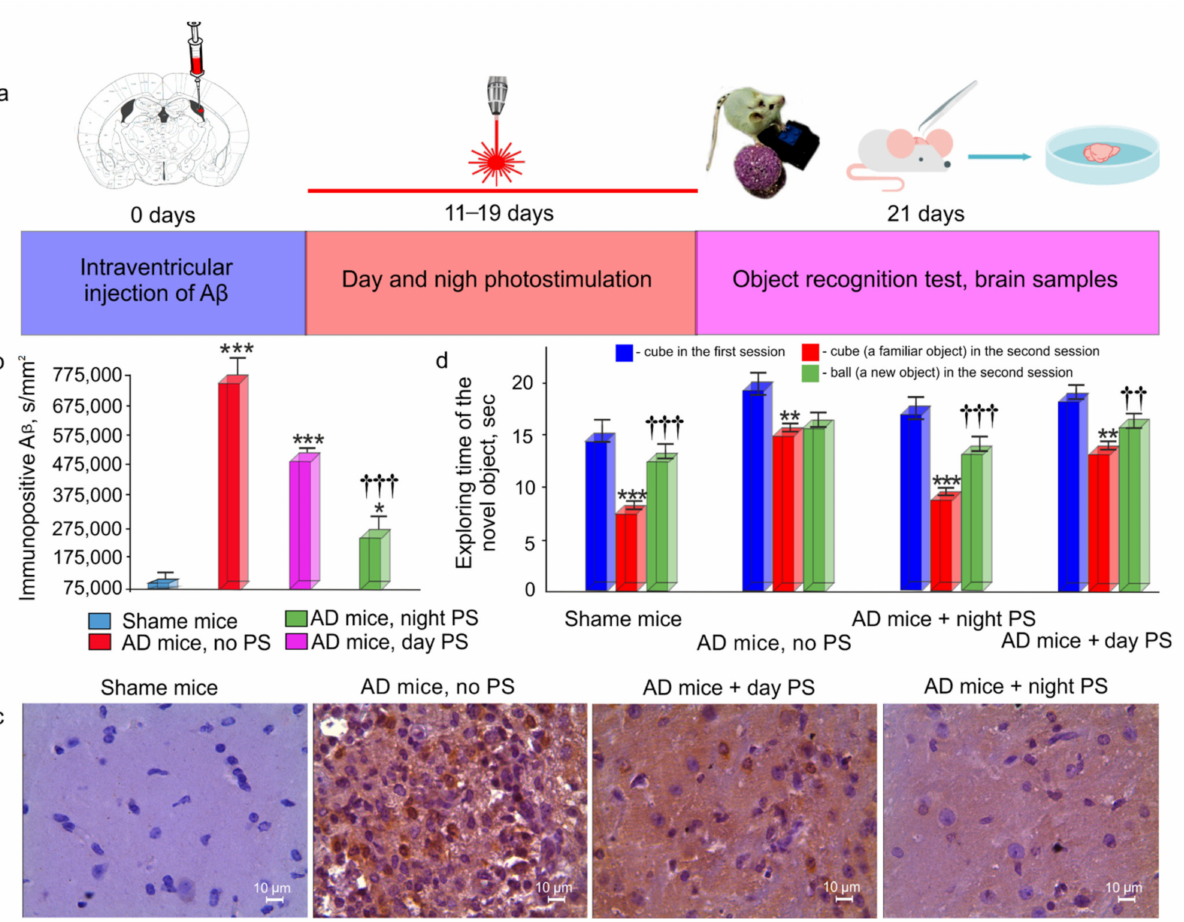
Figure 3. Effects of the 9-day course of PS on the A β deposition in the brain and on recognition memory in the AD mice: ( a ) time points for the intrahippocampal injection of A β , PS application, ORT, and the brain collection; ( b ) quantitation of A β in the brain of the mice in the four tested groups (*** - p < 0.001, * < 0.01 vs. the sham group, ††† - p < 0.001 between the groups treated by PS, two-sample Welch’s t -test, and nonparametric Mann–Whitney U tests, n = 7 in each group); ( c ) representative IHC images of A β in the brain of the mice in the four tested groups; ( d ) object recognition test, reflecting recognition memory (*** < 0.001, ** < 0.05 vs. cubes in the first session; ††† - p < 0.001, †† - p < 0.05 vs. ball in the second session, a one-way ANOVA, n = 7 in each